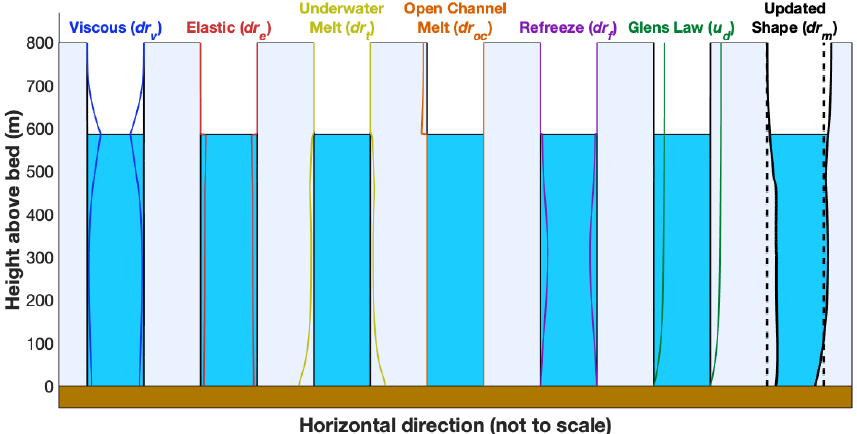
Figure 1. Processes included in the MouSh model. Black lines show a base moulin geometry that each process acts on, and colored lines show the change in moulin geometry (not to scale) due to that process alone. From left to right: changes in moulin geometry due to viscous deformation, elastic deformation, melting by turbulent energy dissipation of flowing water inside the moulin, melting by open-channel water flow, refreezing over winter inside the moulin, and deformation due to ice motion prescribed by Glen’s flow law. Unlike the other components, elastic deformation is instantaneous but applied over the model time step (Sect. 2.2.1; Supplement Sect. S1). The right-most moulin shows the moulin geometry before (dashed black lines) and after (solid black lines and blue water) several hypothetical model time steps, i.e., the sum of all processes shown in the preceding panels. Changes are not to scale.